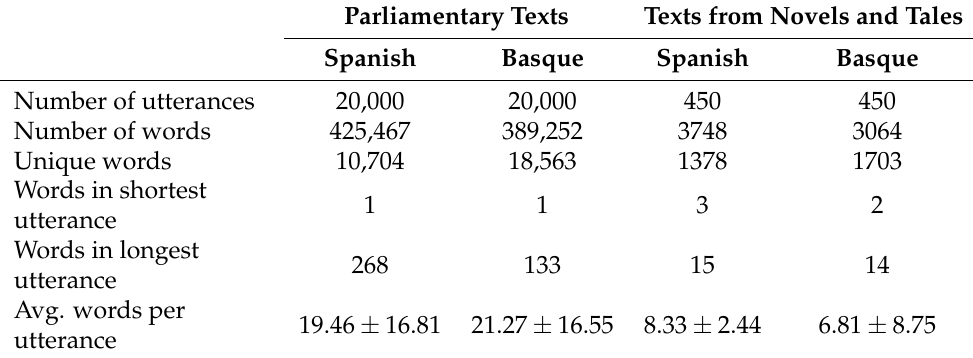
Table 2. Description of the testing